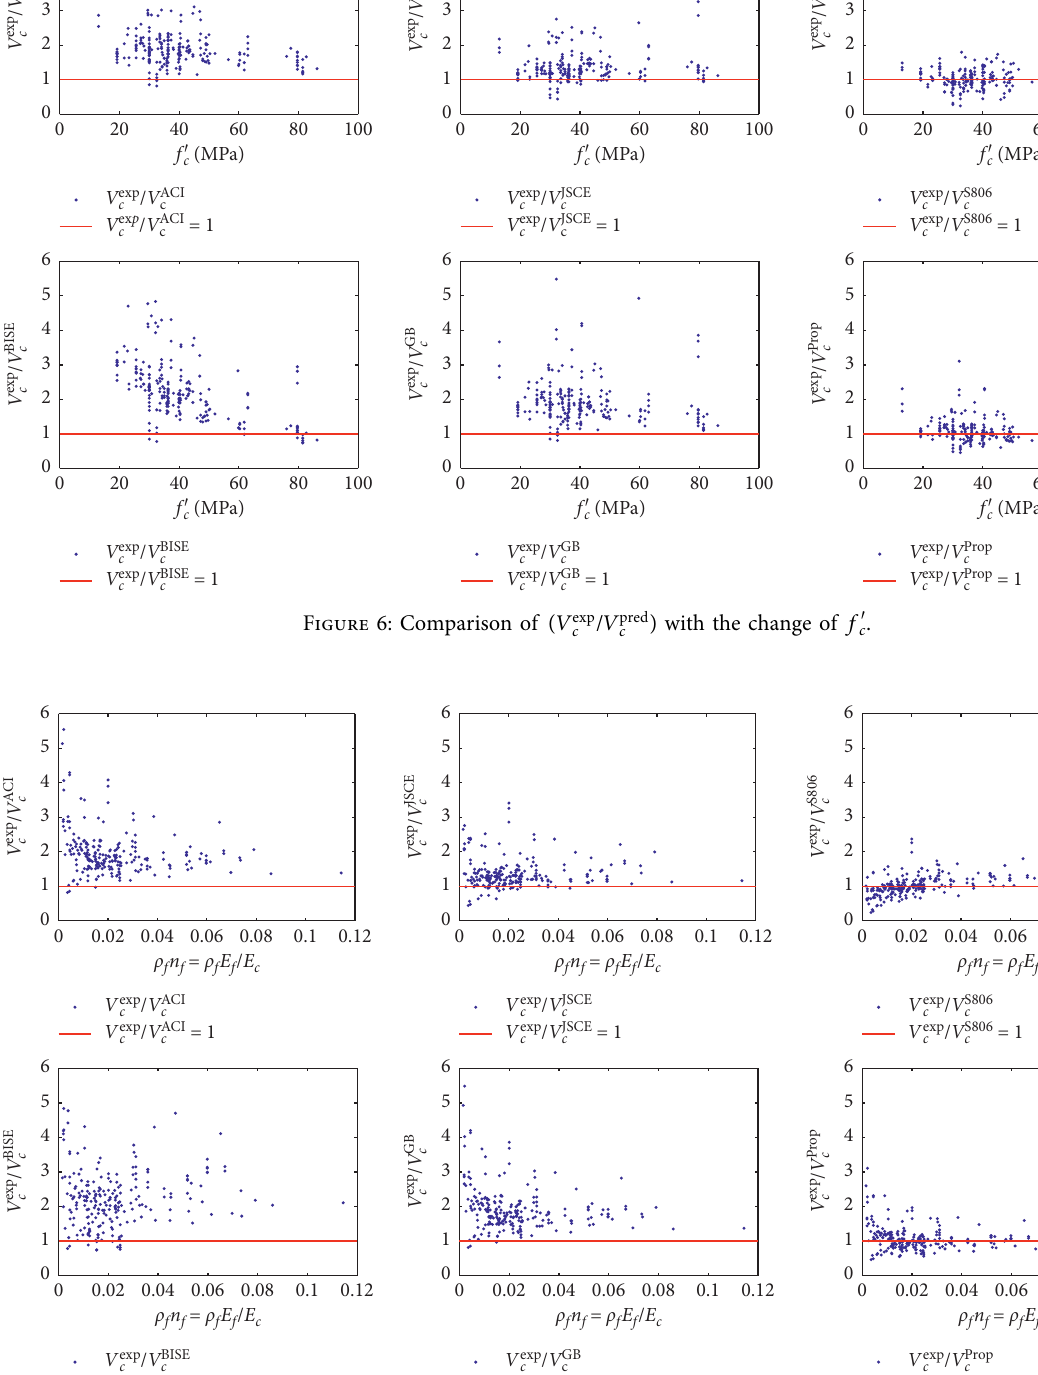
V pred ) with the change of ρ c / c